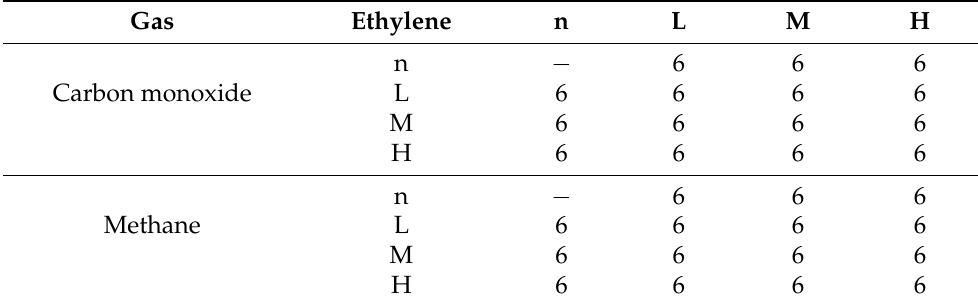
Table 3. Data set category information table.